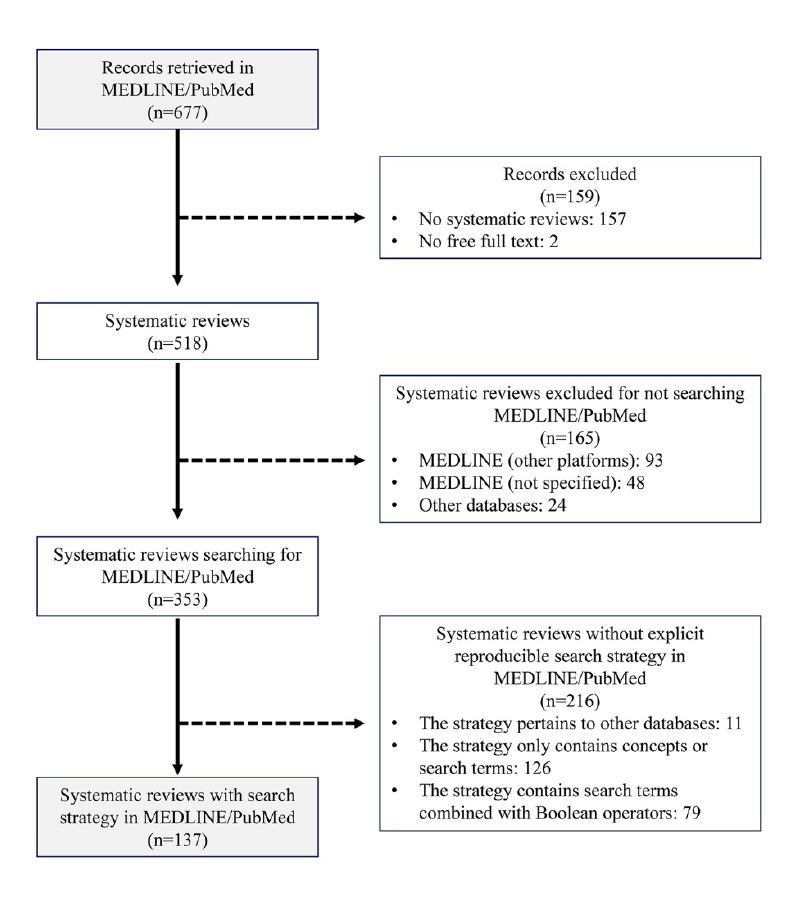
Figure 1 Flow chart of included studies